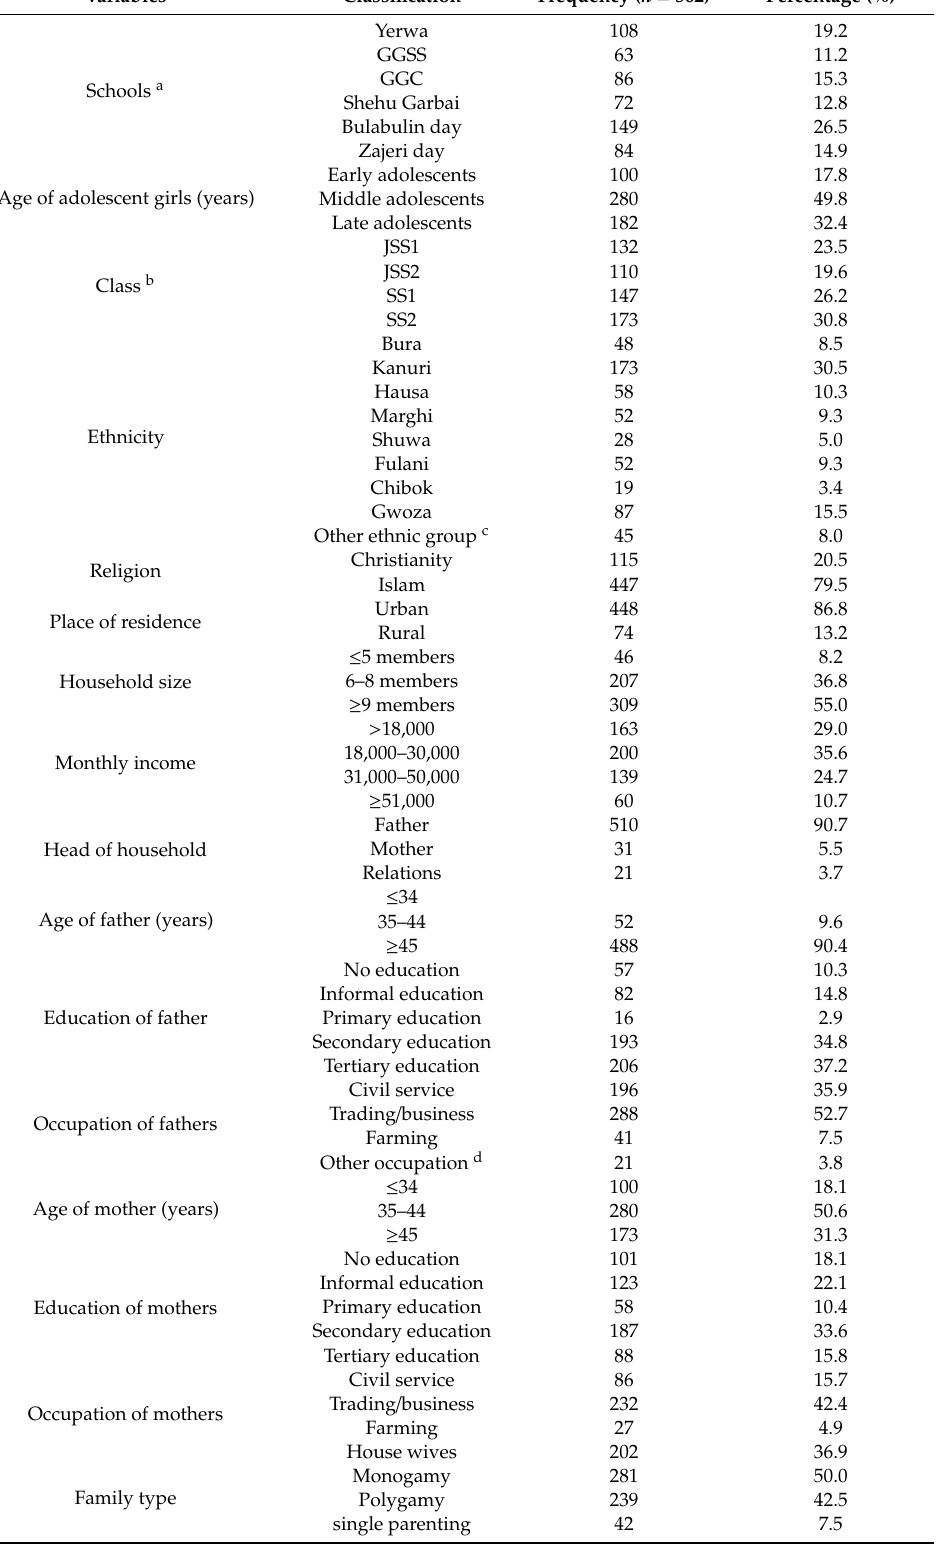
Table 1. Sociodemographic characteristics of respondents ( n =